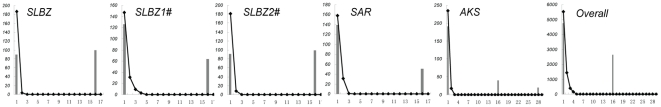
Mismatch distributions of mtDNA of the populations.The histogram shows the observed distribution of pairwise differences between the populations (excluding JMK, which showed only one haplotype) and these populations treated as a whole (Overall). The black line with diamonds shows the expected distribution for a growing population under a population expansion model.